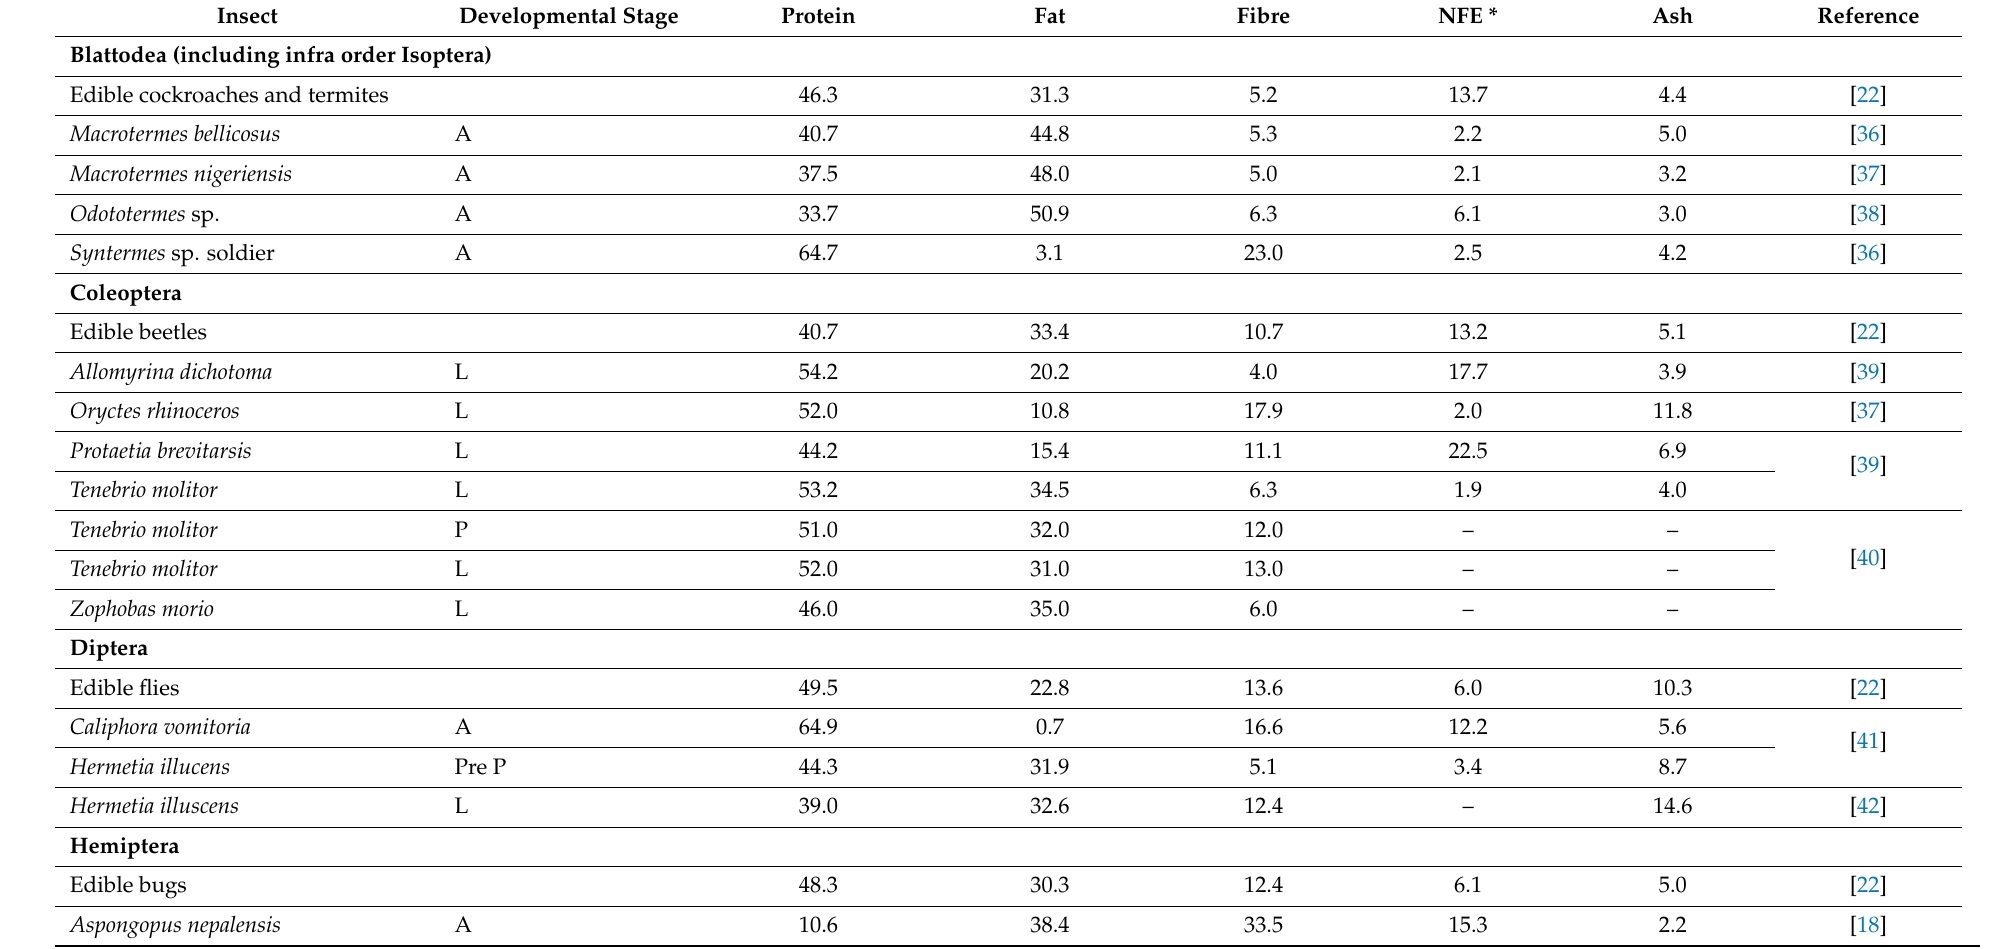
Table 1. Proximate nutrient composition (g/100 g dry matter basis) of edible